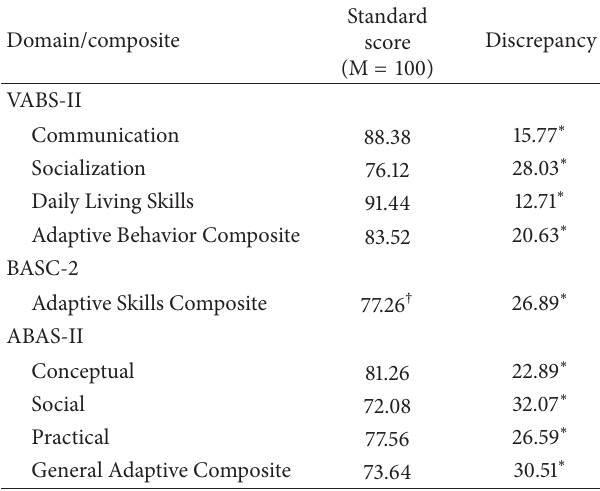
Table 4: Discrepancies between mean IQ and adaptive behavior domain scores and composite